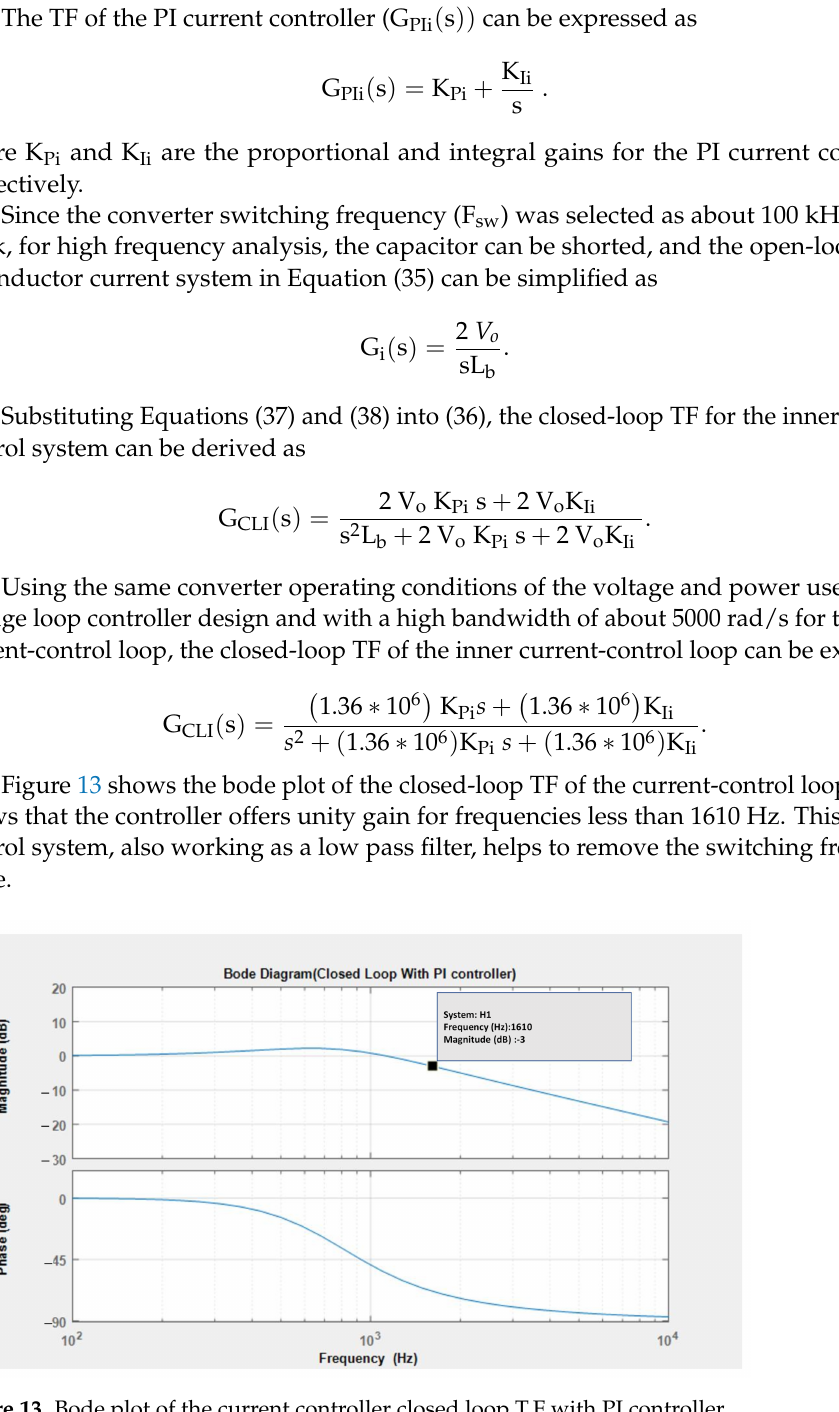
Figure 13. Bode plot of the current controller closed loop T.F with PI controller. The optimal PI controller transfer function designed for the inner voltage control